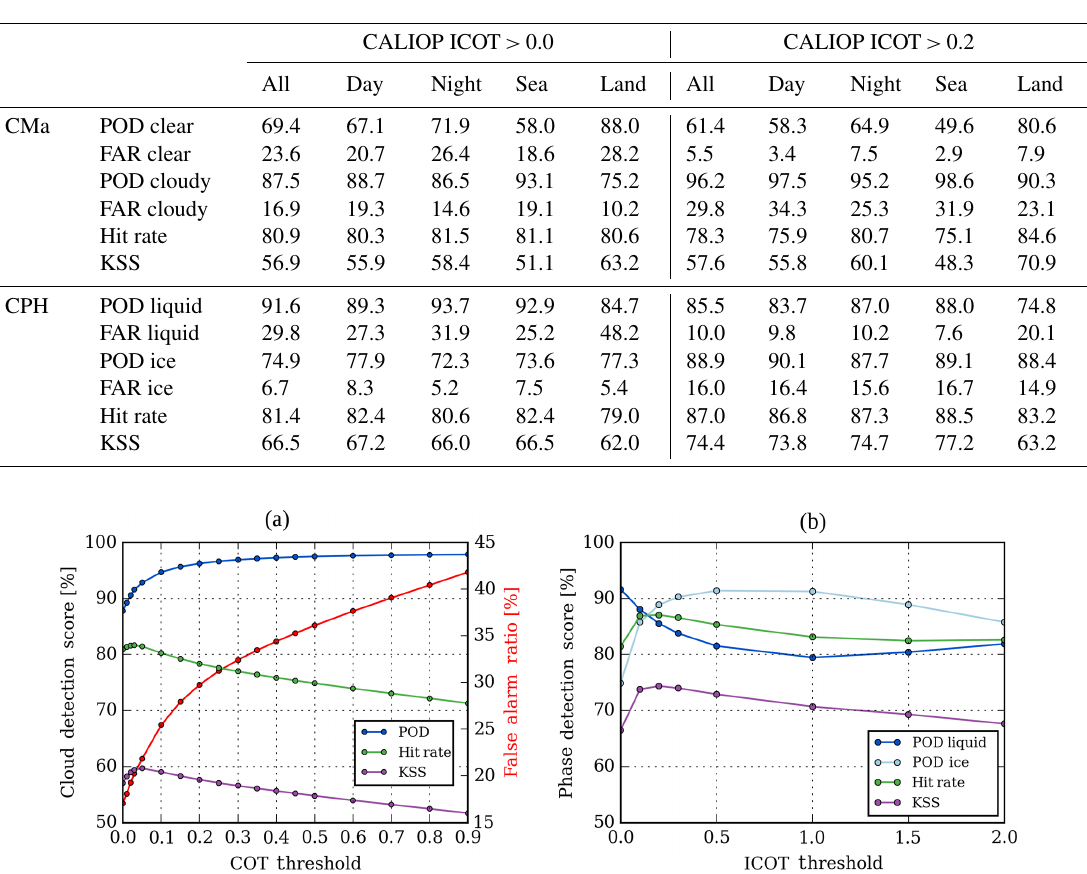
Table 3. Validation results for CLAAS-2 level 2 cloud mask (CMa) and cloud phase (CPH).